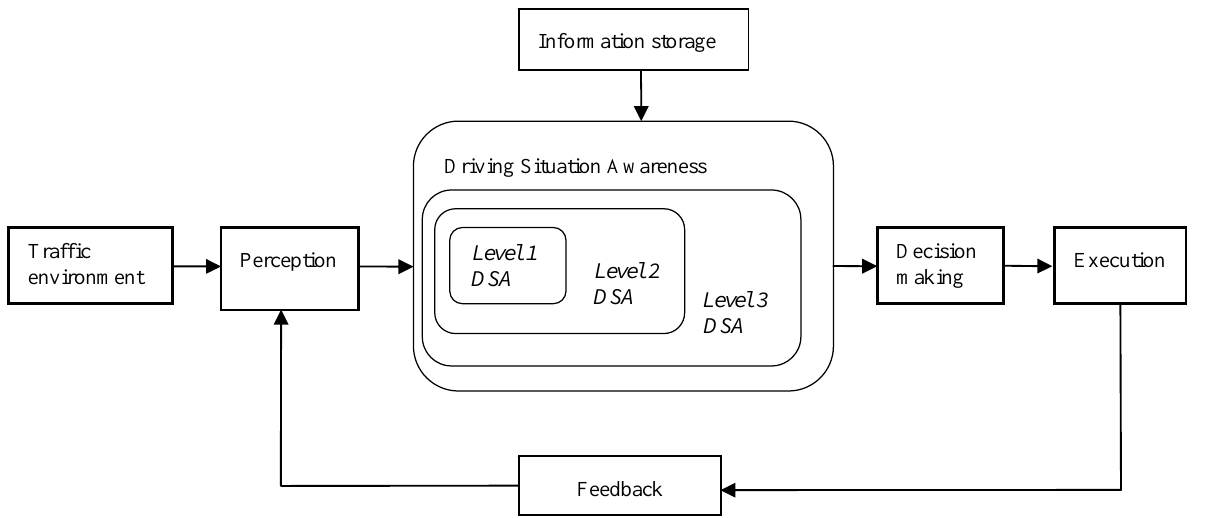
Fig. 2. Driving situation awareness in traffic